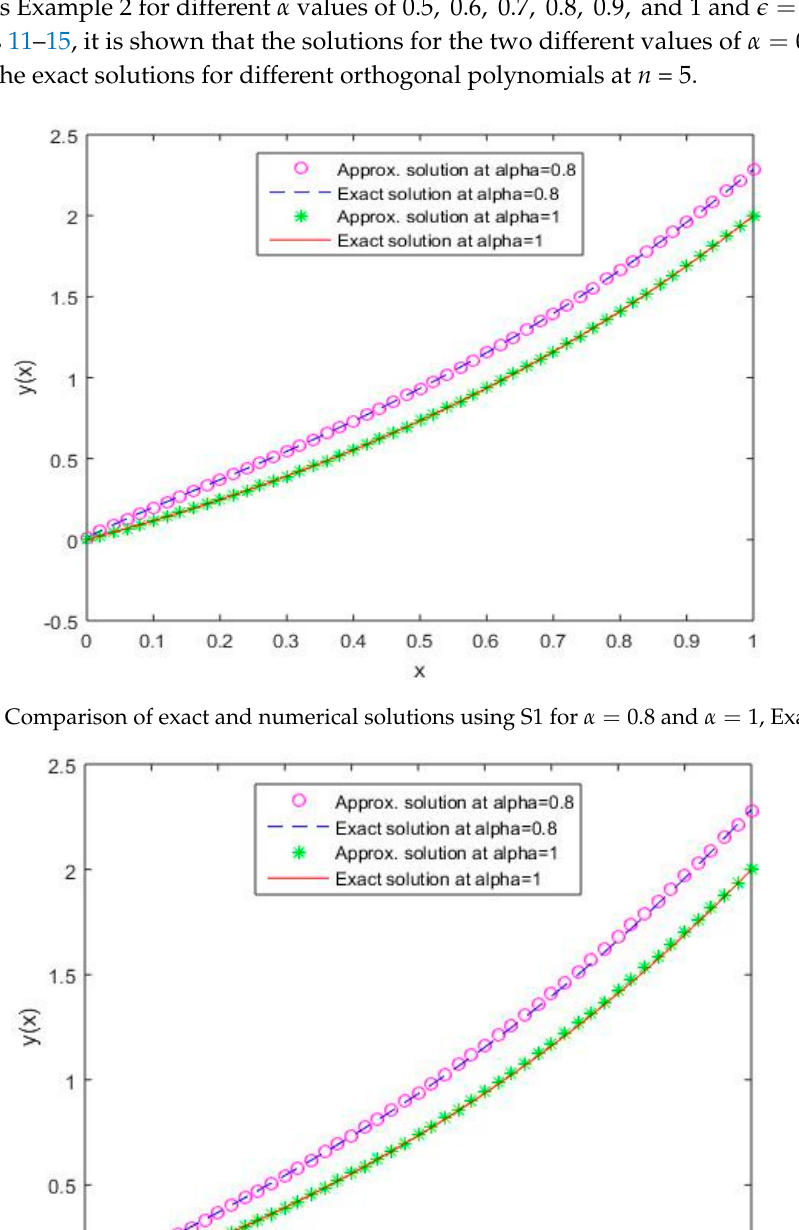
Figure 12. Comparison of exact and numerical solutions using S2 for 𝛼 = 0.8 and 𝛼 = 1 , Example 2.